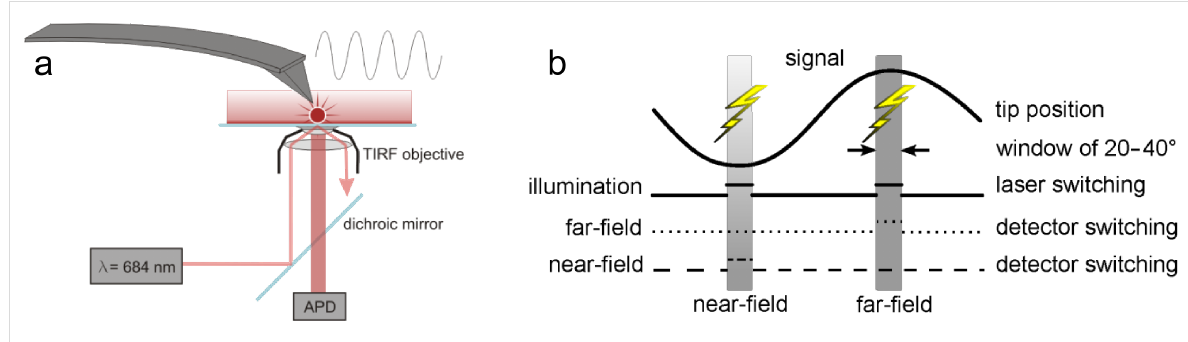
Figure 2: a) Scheme of the experimental setup. b) The sample illumination and fluorescence readout is correlated with the cantilever position. The far-field readout is triggered at the upper reversal point of the cantilever whereas the near-field data is recorded at the lower reversal